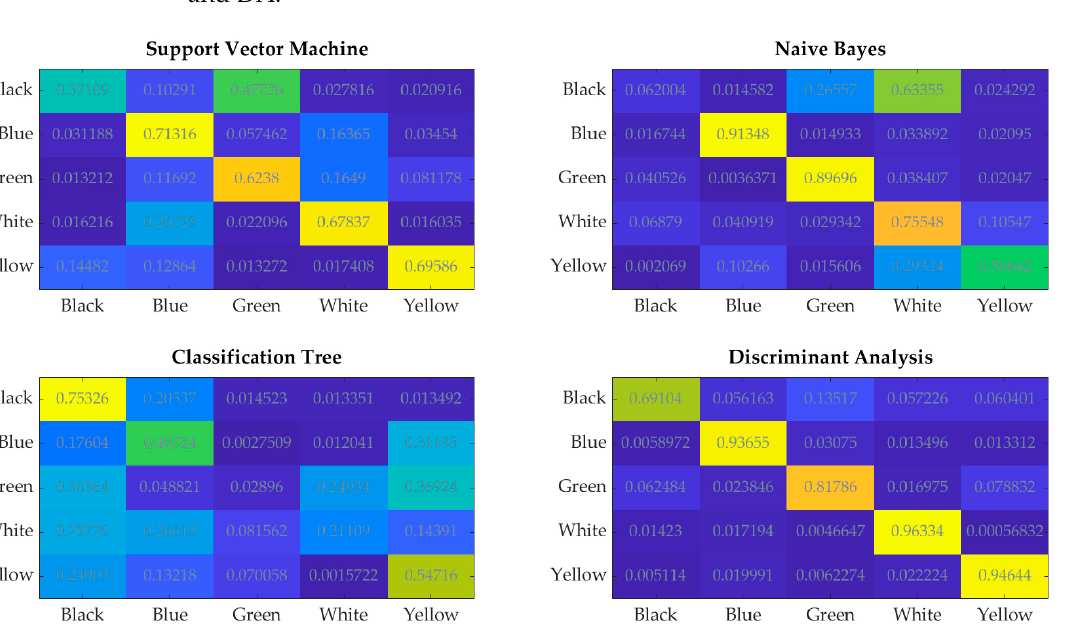
Table 7. The comparison of classification algorithms` performance.